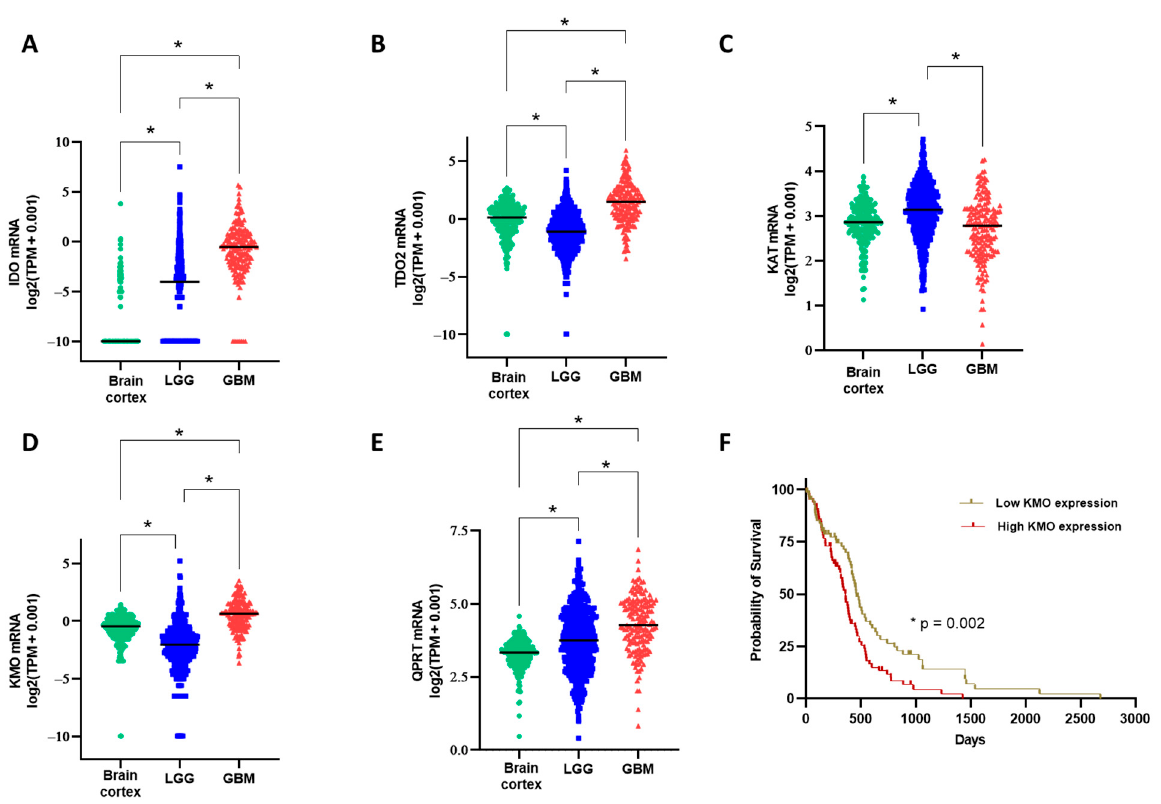
Figure 5. Comparison of gene expression levels (transcripts per million, TPM) on KP enzymes among three groups: brain cortex (non-diseased, GTEx project), low-grade glioma (TCGA program), and GBM (TCGA program). ( A – E ) mRNA expression of indoleamine dioxygenase (IDO), tryptophan dioxygenase (TDO), kynurenine aminotransferase II (KAT2), kynurenine monooxygenase (KMO), and quinolinic acid phosphoribosyl transferase (QPRT). * p < 0.001 based on the Kruskal–Wallis test, with Dunn’s test for pairwise comparisons. ( F ) Kaplan–Meier plot using the data from the GBM group; patients were divided into two groups based on the median KMO expression, and the p -value is based on the log-rank test.